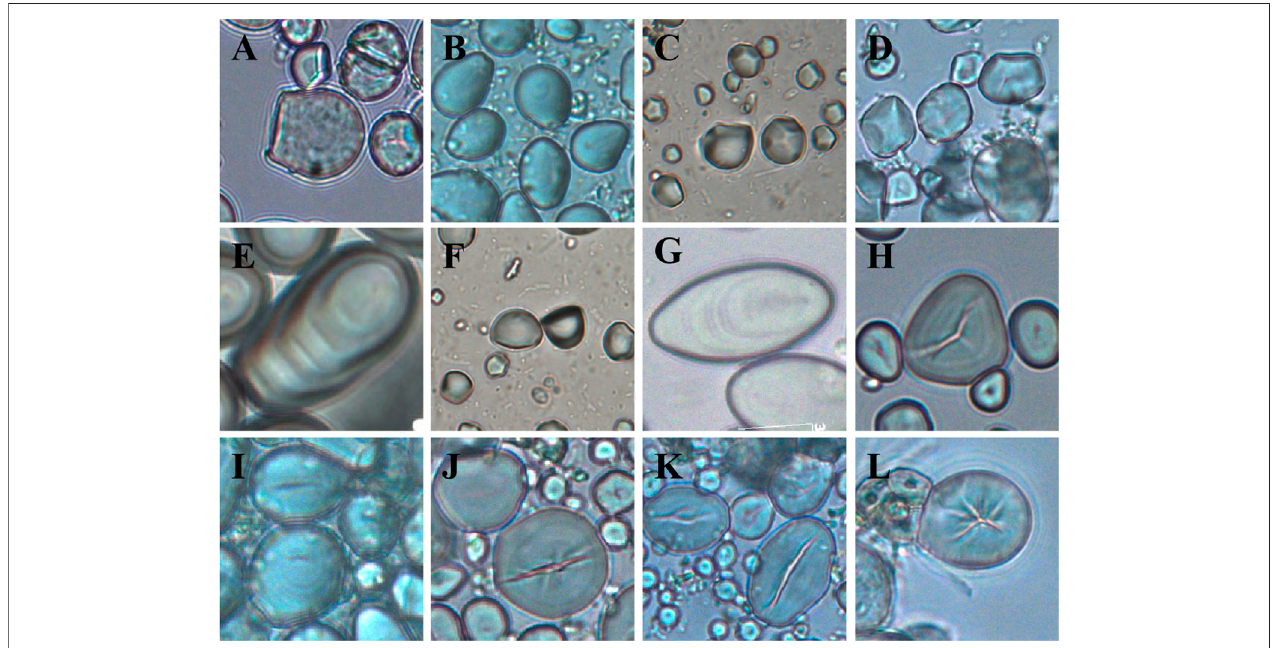
FIGURE 1 | Some of the morphological features considered in this paper: (A) bell-shaped granule with rough surface ( Cyclobalanopsis glauca ); (B) drop-shaped granule ( Quercus cocciferoides ); (C) faceted spherical granule ( Cycas pectinata ); (D) irregular polyhedron granule ( Castanopsis hystrix ); (E) pestle-shaped granule with visible lamellae ( Caryota obtusa ); (F) spherical cap granule ( Cycas pectinata ); (G) spindle-shaped granule with visible lamellae ( Arenga westerhouti i (red)); (H) , triangle granule with v-shaped fi ssure ( Quercus variabilis ); (I) linear fi ssure; (J) and (k) longitudinal fi ssure; (L) , stellate fi ssure.